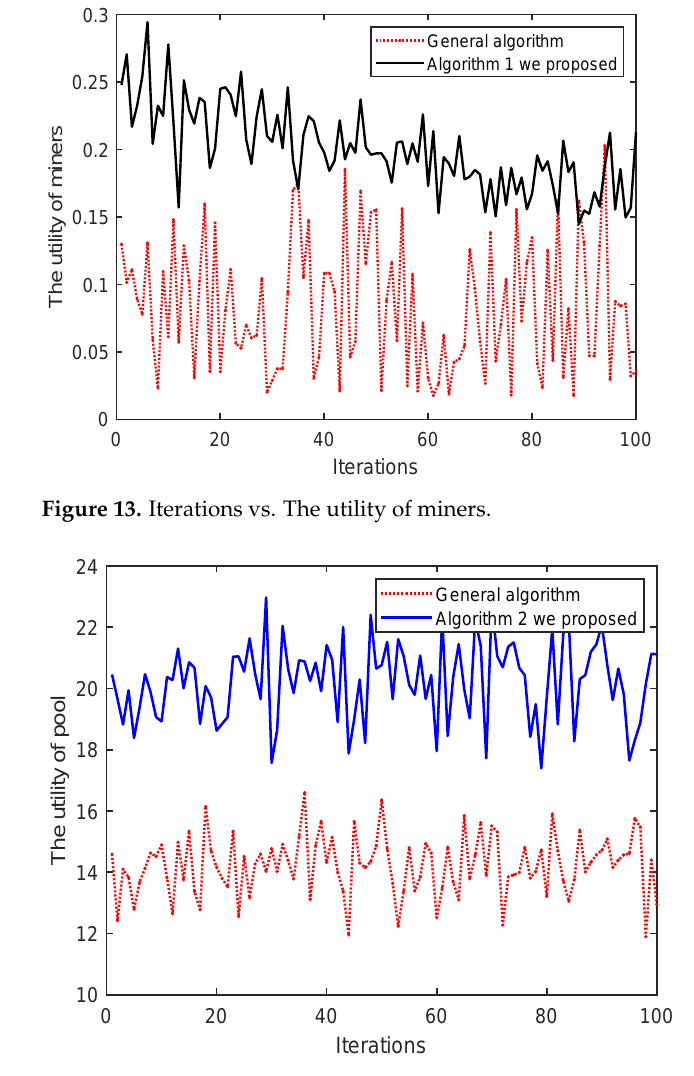
Figure 14. Iterations vs. The utility of